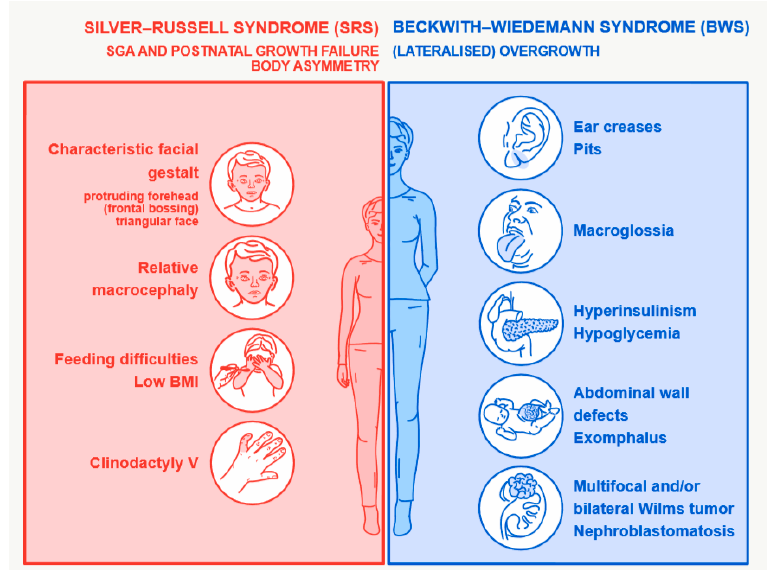
Figure 1. Major clinical features of Silver–Russell syndrome (SRS) and Beckwith–Wiedemann syndrome (BWS).